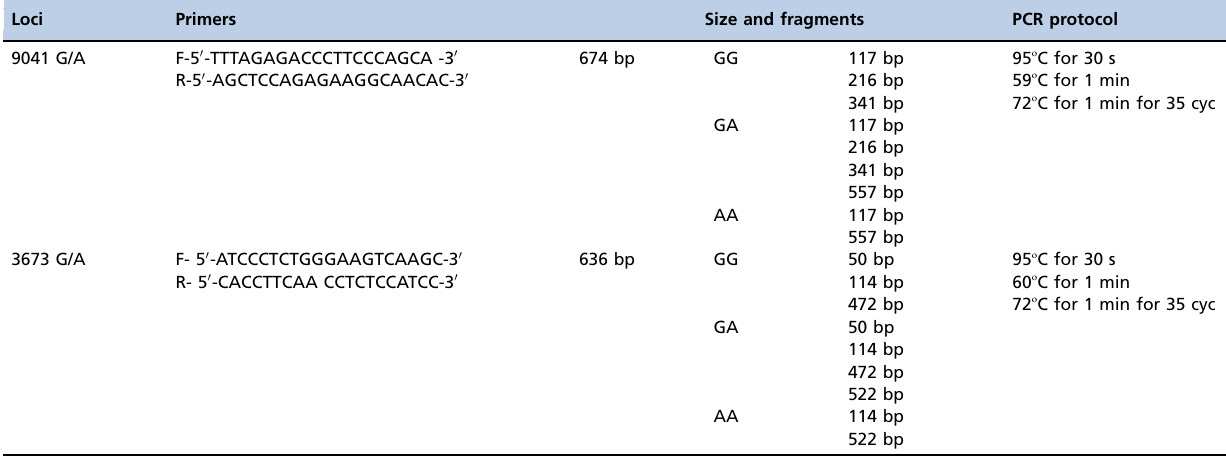
Table 1 - PCR protocols and primer sequences for amplification of different loci of the vitamin K reductase complex subunit 1 (VKORC1) gene. Loci Primers